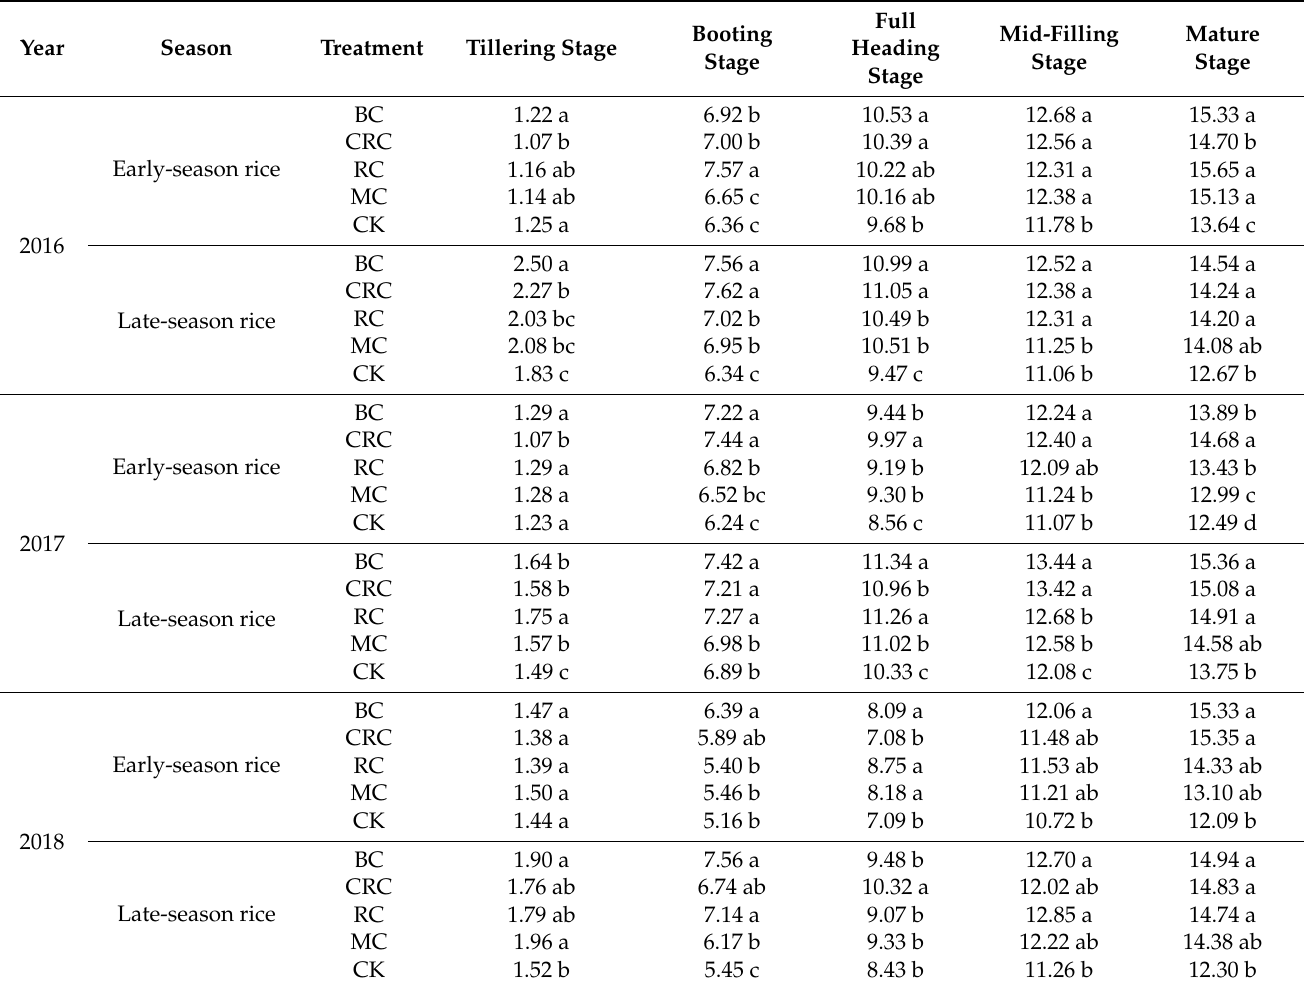
Table 3. Dry matter accumulation under different organic material treatments in 2016–2018 (t ha − 1